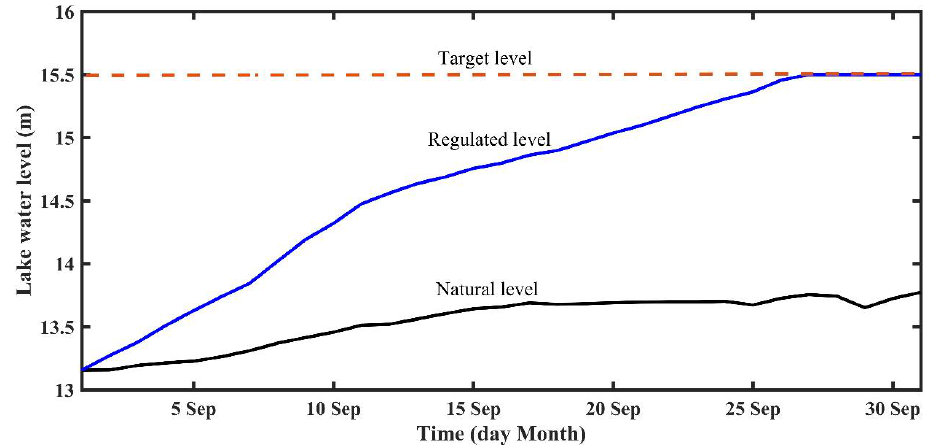
Figure 5. Time series changes in lake water levels at the control point of the PLHP for the natural and regulated conditions.